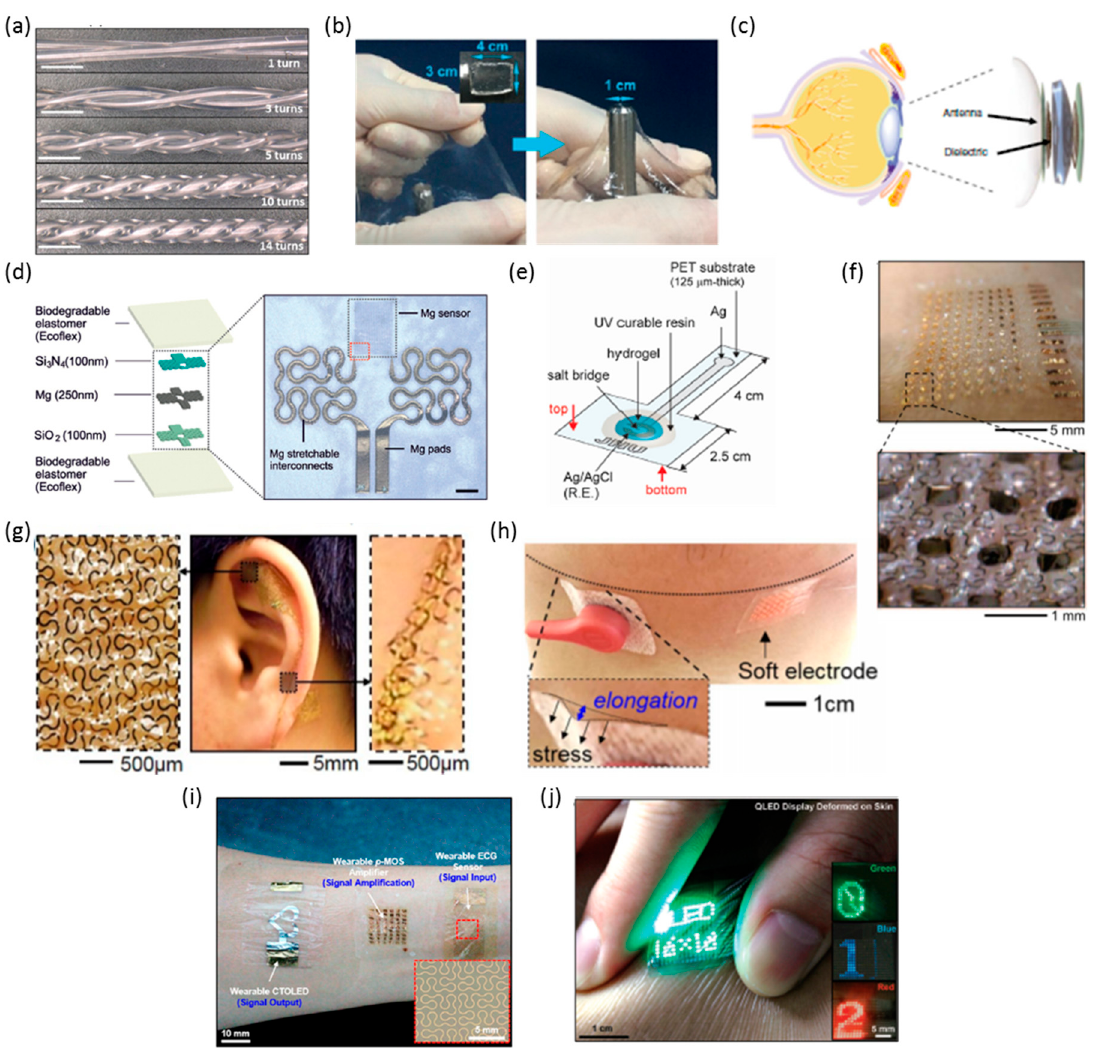
Figure 2. Wearable electronic systems. ( a ) Microtubule strain sensor and interconnect. Reprinted